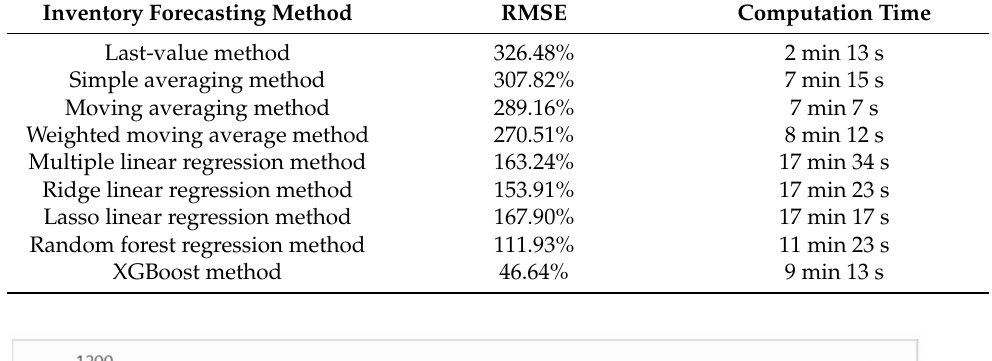
Table 5. The comparison table of different forecasting methods’ computation time and accuracy.